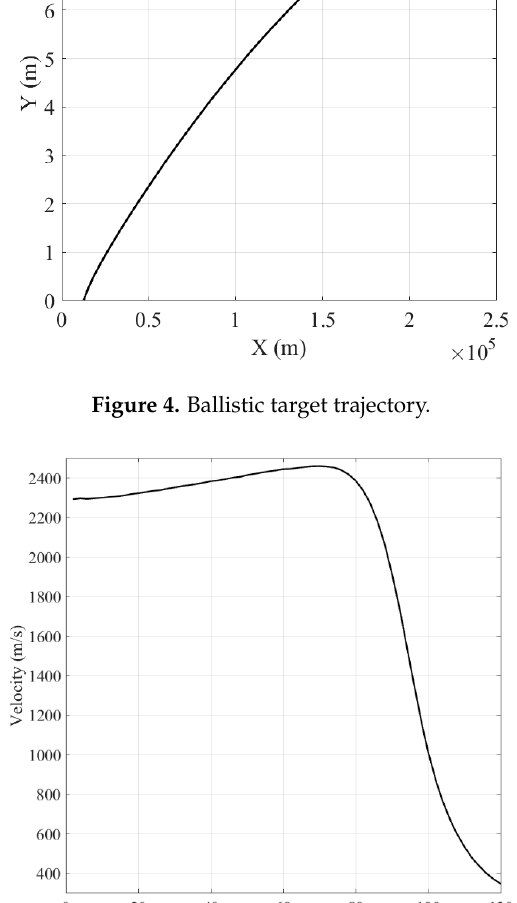
Figure 6. Aerodynamic drag acceleration against time The proposed Gaussian mixtures fusion method is verified by comparing the results between sensors S 1 and S 2 . Note that the estimate from sensor S 1 is identical to the fused result, for the reason that after each fusion the local track from sensor S 1 is replaced with the fused track from the fusion